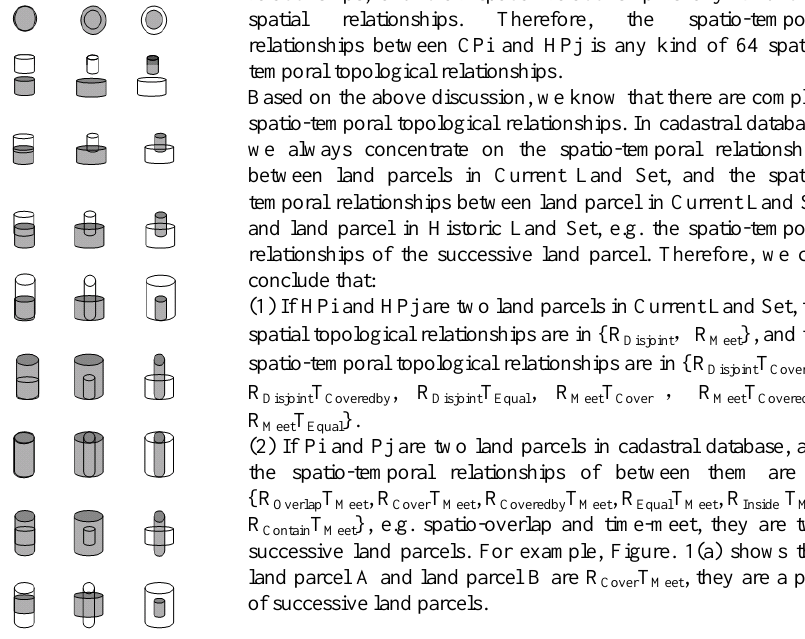
Figure 2. spatio-temporal relationships between land parcels in cadastral temporal